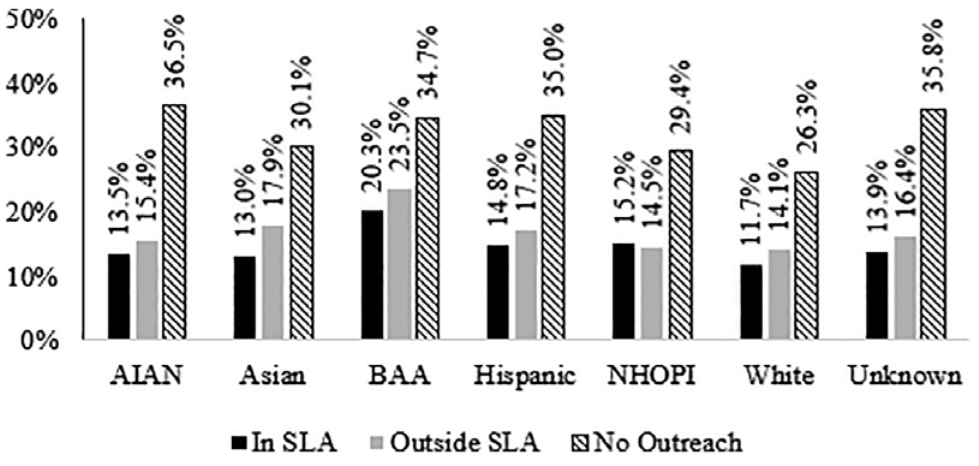
Figure 6. Drop Rate by Self- Reported Race/Ethnicity and Service Level Agreement